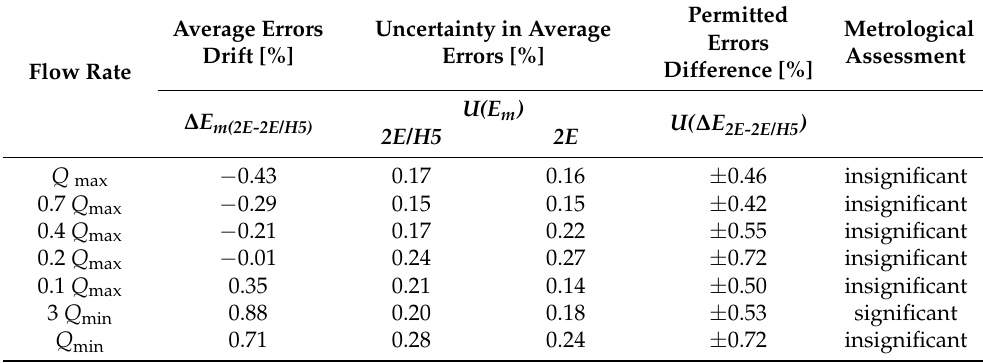
Table 7. Metrological assessment of average error of indication drift of ultrasonic G4 gas meters with 2E/H5 and 2E/H0. Permitted Metrological Average Errors Uncertainty in Average Errors Assessment Drift [%] Errors [%] Difference [%] Flow Rate U(E m ) ∆ E U( ∆ E 2E-2E/H5 ) m(2E-2E/H5) 2E/H5 2E Q max − 0.43 0.17 0.16 ± 0.46 insignificant